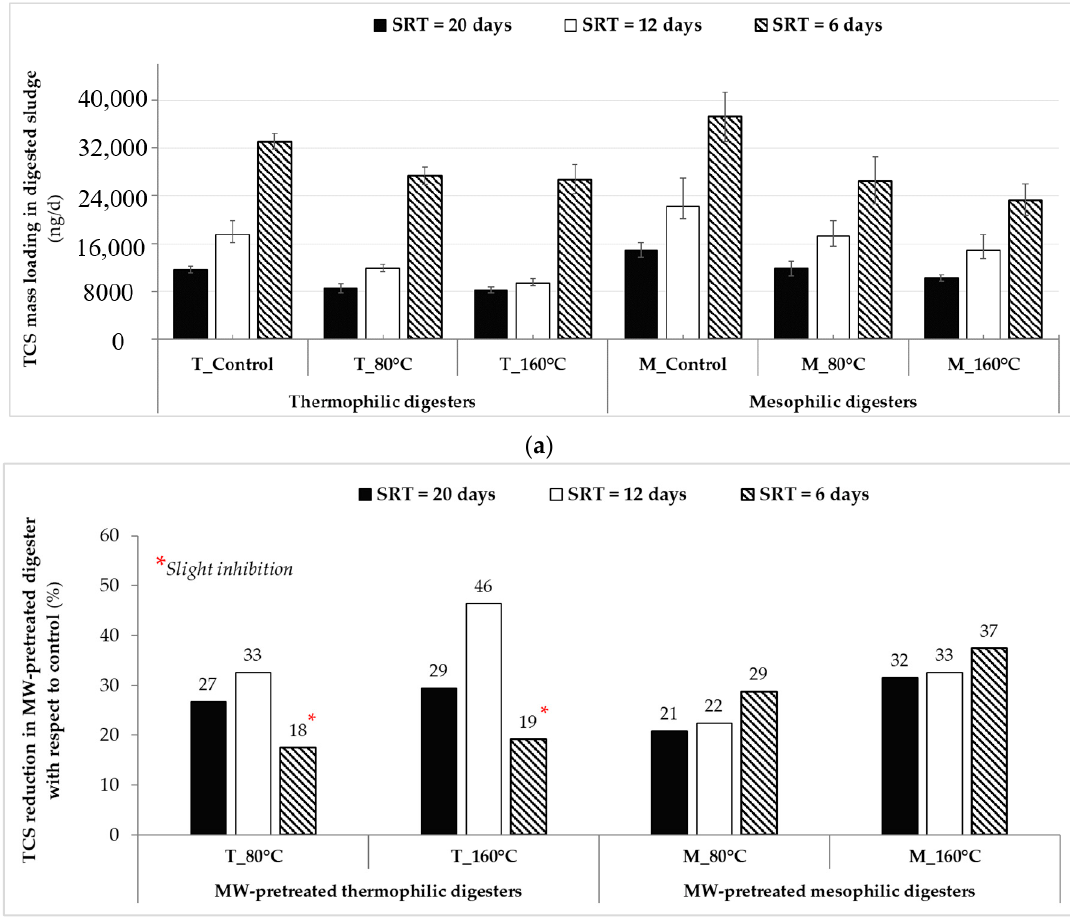
Figure 6. ( a ) Daily triclosan (TCS) mass loadings in anaerobically digested sludge obtained from thermophilic and mesophilic digesters at sludge retention times (SRTs) of 20, 12, and 6 days during steady-state, and ( b ) the reduction percentage of TCS mass loadings exiting from MW-pretreated digesters compared to their respective control digesters.